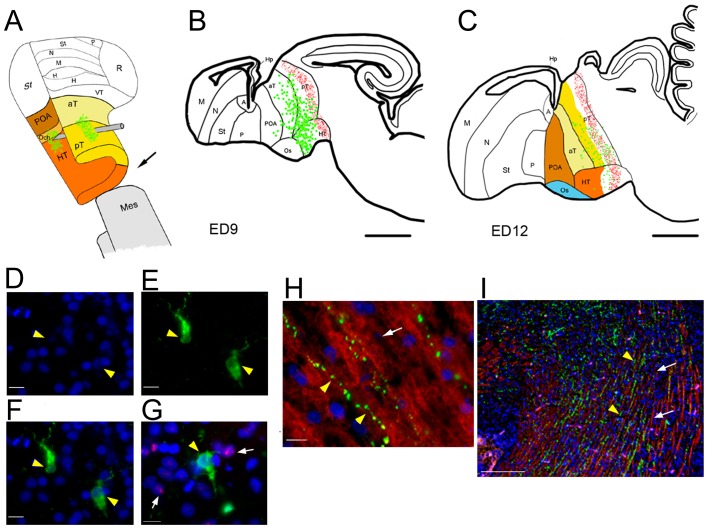
Localization of finch GFP positive cells in the chimera.(A) 3D diagram of the zebra finch neural tube, referring to the chicken cell fate map [39] showing the GFP plasmid injection location (green) in the zebra finch and cutting edge during the transplantation. (B–C) GFP positive cells (green dots) and the boundary between the zebra finch and quail tissue (red dots) are labeled on the sagittal brain contour of chimeras at ED9 (B) and ED12 (C). (D–F) Images of the same section from the chimeric thalamus showing DAPI only, GFP positive cells, and a merging of the two images, respectively. GFP positive cells do not have condensed heterochromatin in the nucleolus, confirming that they are zebra finch cells. (G) Image showing the fusion area in the thalamus region labeled with a zebra finch GFP positive cell (without condensed stained nucleolus; yellow arrowhead) intermingled with QCPN positive quail cells (with a condensed stained nucleolus; white arrows). (H–I) GFP positive cell fibers (green; yellow arrowheads) do not overlap with quail neuronal fibers that stain with the quail neuronal marker QN (red; white arrows). Scale bar = 1 mm in B–C, 10 µm in D–H, and 250 µm in I.